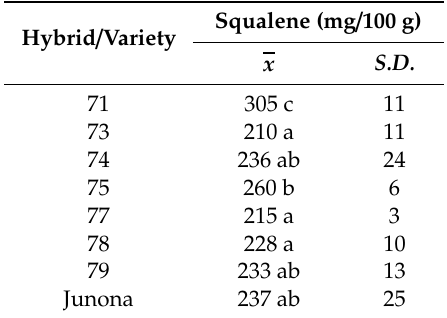
Table 5. Squalene content in total content of lipids from seeds of studied Styrian oil pumpkins. Hybrid /